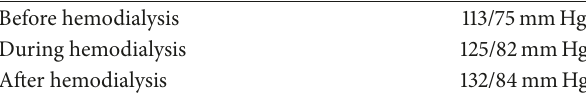
Table 1: Blood pressure monitoring and time relation with hemodialysis.